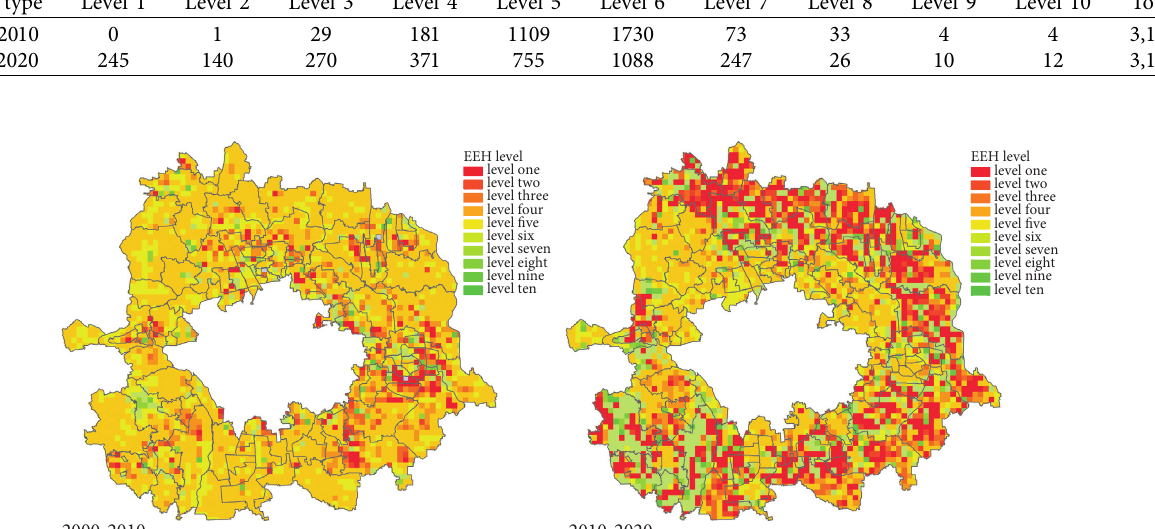
Figure 8: EEH change of grid units in the second green isolation area (2000–2020).